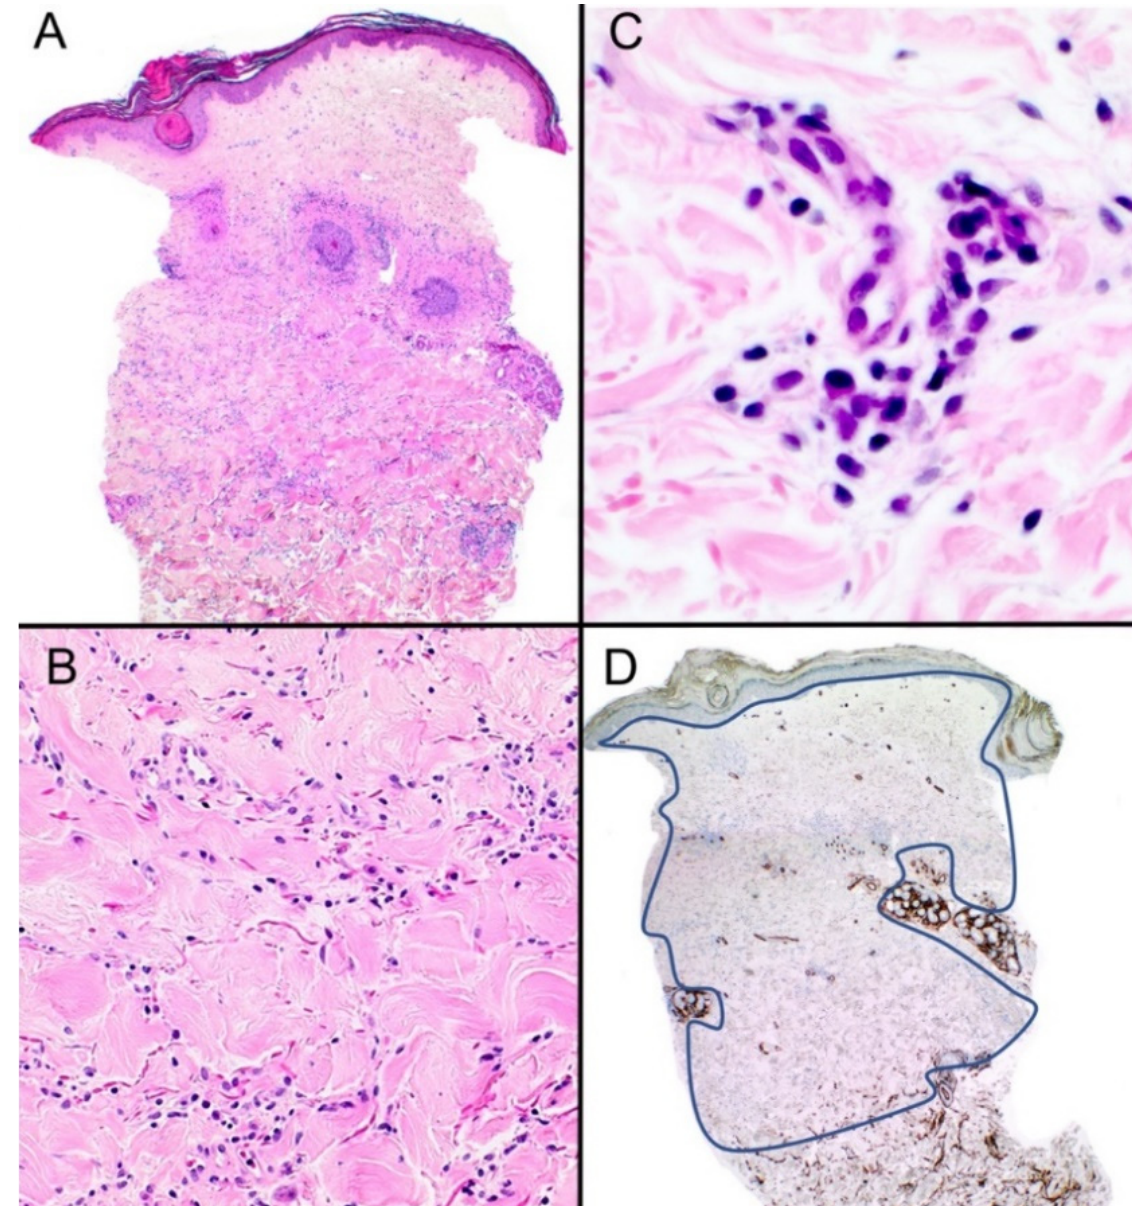
Figure 2. ( A ) Scanning magnification of this punch biopsy with hyperkeratosis, follicular plugging, and hyalinization of collagen in the superficial dermis (H&E) ×40. ( B ) Higher magnification shows an interstitial inflammatory cell infiltrate composed predominantly of lymphocytes (H&E) ×100. ( C ) Plasma cell also seen in the infiltrate (H&E) ×200 ( D ) There is diffuse loss of CD34 expression throughout the dermis (as demarcated by the blue line) ×40.